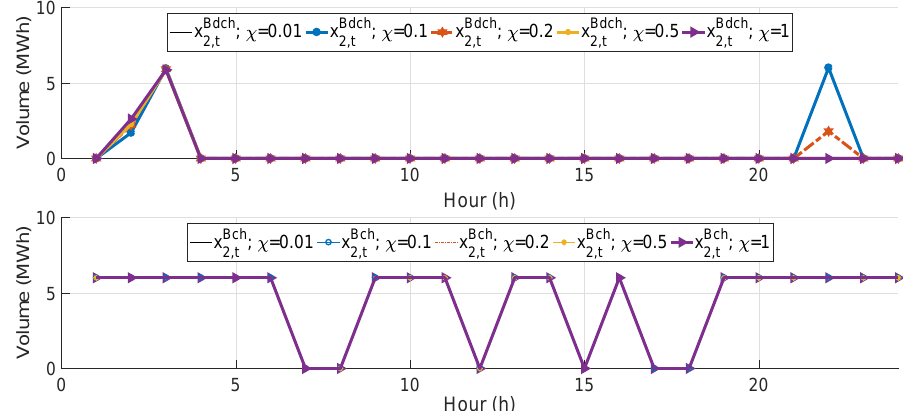
Figure 11. Real-time trading strategies; T-CVaR risk aversion shift in real-time bids of 24 h of planning day (upper figure-discharging bids, lower figure-charging